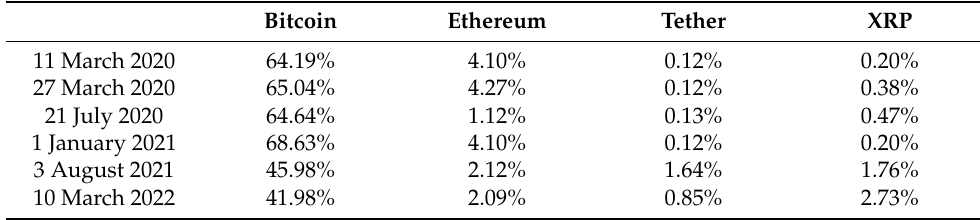
Table 1. Major cryptocurrencies by percentage of total market capitalization.